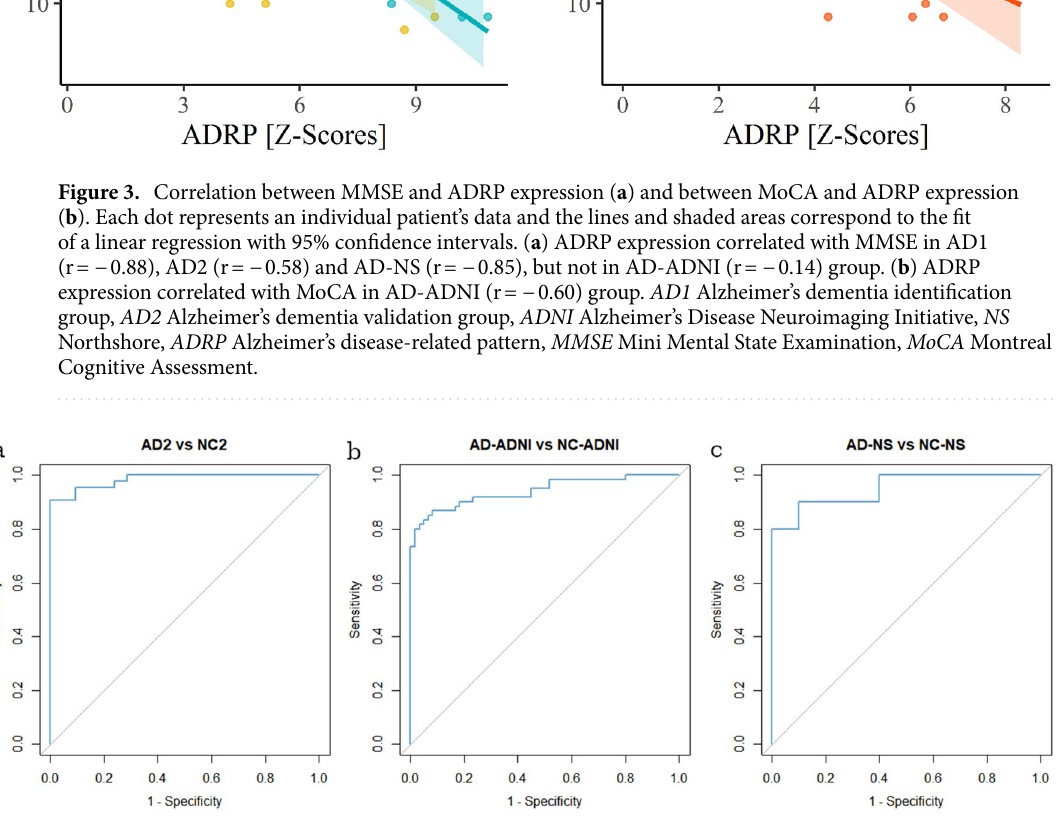
Fig. 6. ADRP subject scores did not correlate with language Index score ( r (13) = −0.44, p = 0.105) or delayed memory Index score ( r (13) = −0.299, p = 0.278). The mean pattern expression was significantly higher in both AD1 ( M = 5.9, SD = 2.5) and AD2 ( M = 4.9, SD = 2.1) compared to MCI Alz group ( M = 1.9, SD = 1.8), t (45) = 6.4, p < 0.001 and t (68) = 6.0, p < 0.001, respec- tively. ADRP expression differed significantly between NC2, MCI Alz and MCI nonAlz ( F (2, 60) = 9.5, p < 0.001). It was significantly higher in MCI Alz ( M = 1.9, SD = 1.8) compared to NC2 ( M = −0.1, SD = 1.5), p < 0.001 and also in comparison to MCI nonAlz ( M = 0.6, SD = 1.6), p = 0.032. ADRP expression did not differ between MCI nonAlz and NC2 groups, p = 0.46, Fig. S1. However, we observed a significant difference in age between NC2 ( M = 62.6, SD = 6.6), MCI nonAlz ( M = 67.8, SD = 5.9) and MCI Alz ( M = 73.7, SD = 6.1) groups ( F (2, 60) = 19, p < 0.001) and after adjustment for age difference ADRP expression was no longer significantly different between